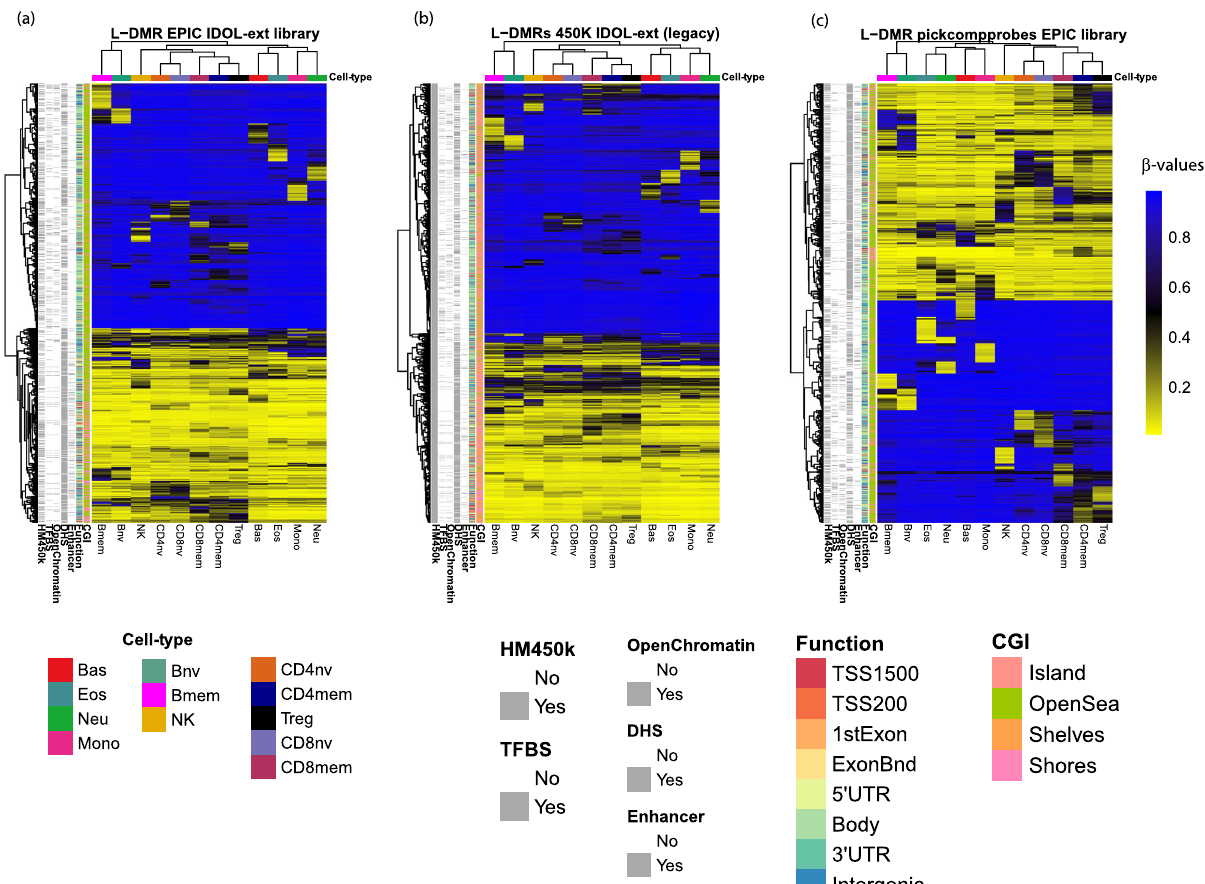
Fig. 3 Comparison of the selected CpG among the EPIC IDOL-Ext, 450k IDOL-Ext (legacy), and pickComProbes. a DNA methylation of the 1200 CpG probe EPIC IDOL-Ext library with average methylation for cell-type samples shown in columns as labeled and tracking bars for CpG probes information in the rows, including: present on 450k array (HM450k), tracking to transcription factor binding site (TFBS), DNA hypersensitivity site (DHS), enhancer region from Phantom5 annotation, and genomic context relative to gene (Function) and CpG island (CGI). b DNA methylation of the 1500 CpG probe 450k IDOL-Ext (legacy) library and c DNA methylation of the 1200 CpG pickComProbes library. The average DNA methylation levels (here as beta values) are represented per each of the 12 cell types. Information about CpG island gene context, Phantom5-enhancer information, DNase Hypersensitivity sites (DHS), Open chromatin, and annotated transcription factor binding sites (TFBS) from ENCODE included in the Illumina annotation fi le are summarized using the row ribbons. Source data are provided as a Source Data fi le. Bas Basophils, Eos eosinophils, Neu neutrophils, Bnv B-cells naïve, Bmem B-cells memory, CD4nv helper CD4( + ) T-cells naïve, CD4mem helper CD4( + ) T-cells memory, Treg CD4( + ) T regulatory cells, CD8nv cytotoxic CD8( +